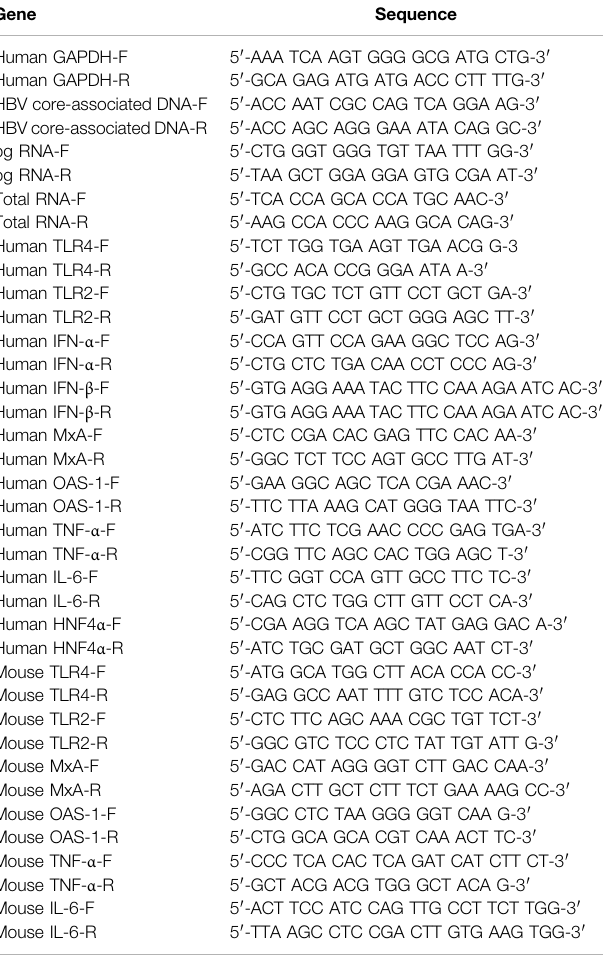
TABLE1 | Gene sequence Gene Sequence Human